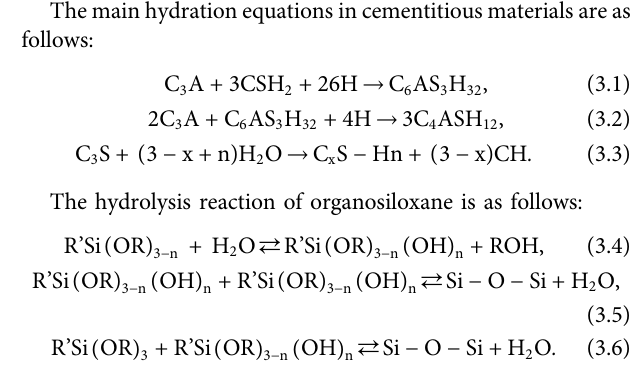
Frontiers in Materials |